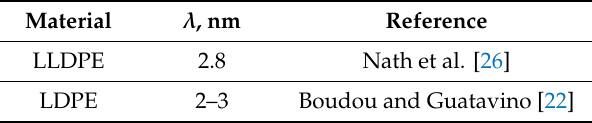
Table 5. Trap site separation λ in LDPE.